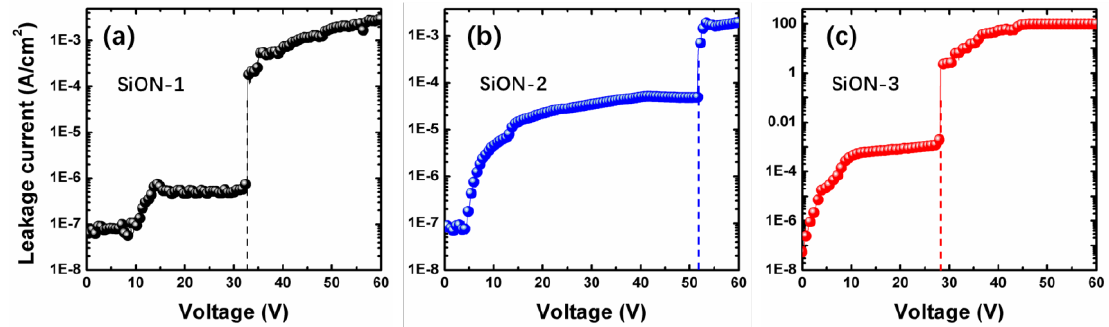
Figure 10. J− V curves of the ( a ) SiON-1, ( b ) SiON-2, and ( c ) SiON-3 dielectrics on Si substrate.